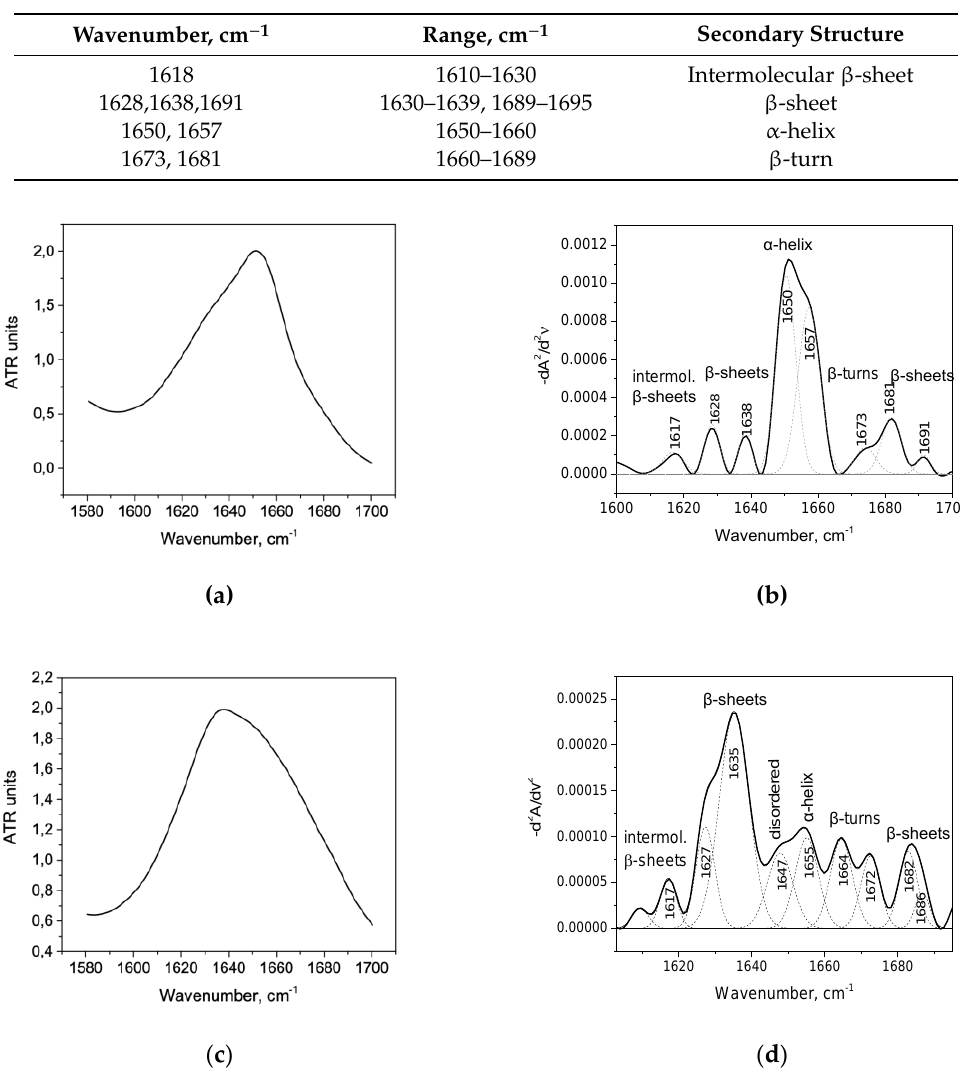
Figure 1. The Amide I band ( a ) and its second derivative deconvolution ( b ) of native human serum albumin (HSA) in 10% wt. aqueous solution. The Amide I band ( c ) and its second derivative deconvolution ( d ) of native trypsin 20% wt. aqueous solution.